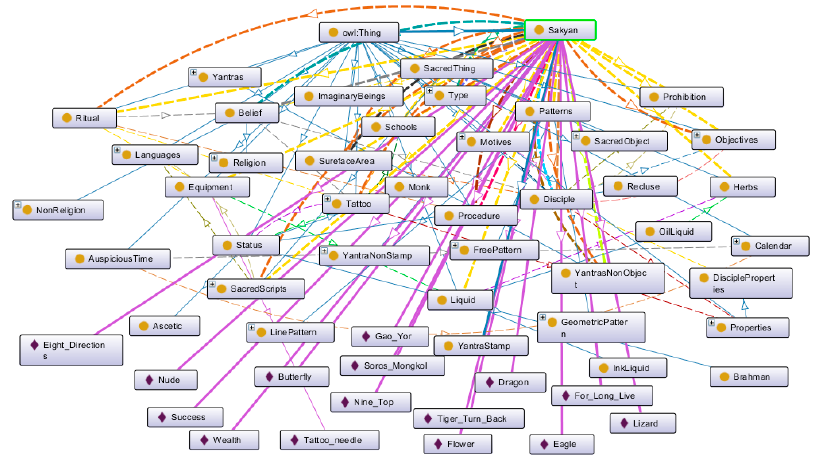
Figure 4. Instances or individuals of Sak Yan ontology.